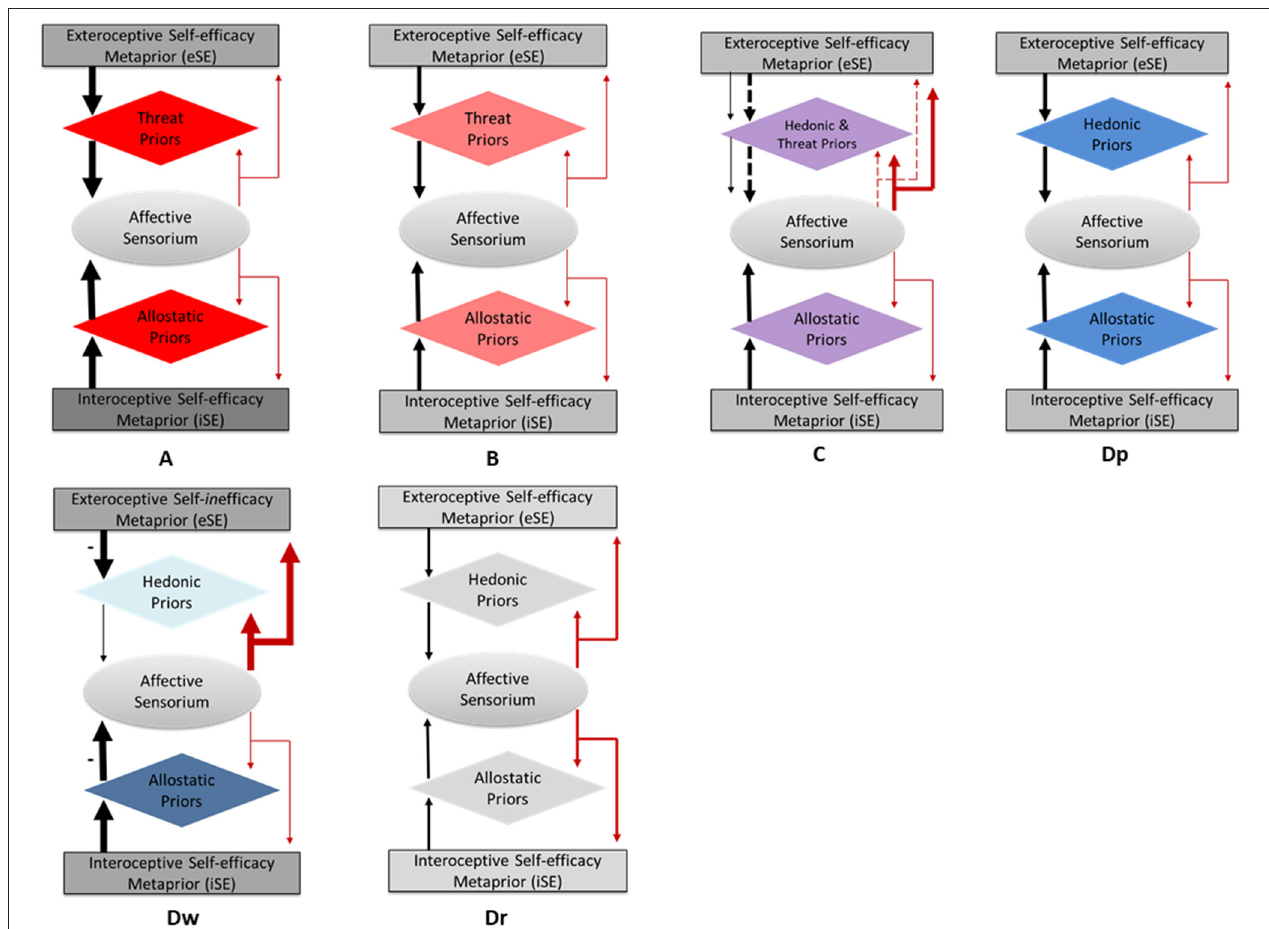
FIGURE 1 | The continuum of precision-weighting dysregulation in affective disorders. (A) Traumatic stress response, (B) anxiety stress response, (C) mixed, anxiety-depressive stress response, (Dp) the protest stage of depressive stress response, (Dw) the withdrawal stage of depressive stress response, (Dr) the recovery stage of depressive stress response. The oval boxes represent affective sensorium including all affectively valenced sensations, both extero- and interoceptive. The rhombic boxes represent priors. The rectangular boxes represent self-efficacy metapriors. The intensity of the box’s hue reflects the precision of the corresponding priors, and the thickness of arrows reflects the precision of the corresponding predictions. Black arrows represent predictions; red arrows represent prediction errors. The arrows point in the direction of information passaging. (C) The dashed arrows represent thereat-related predictions and prediction errors; the solid arrows represent hedonic predictions and prediction errors. (Dw) The minus sign by the downward arrow indicates the negative value of the self-efficacy metaprior, i.e., self- in efficacy. The minus side by the upward arrow indicates energy-conserving predictions (as opposed to energy expenditure predictions in the other